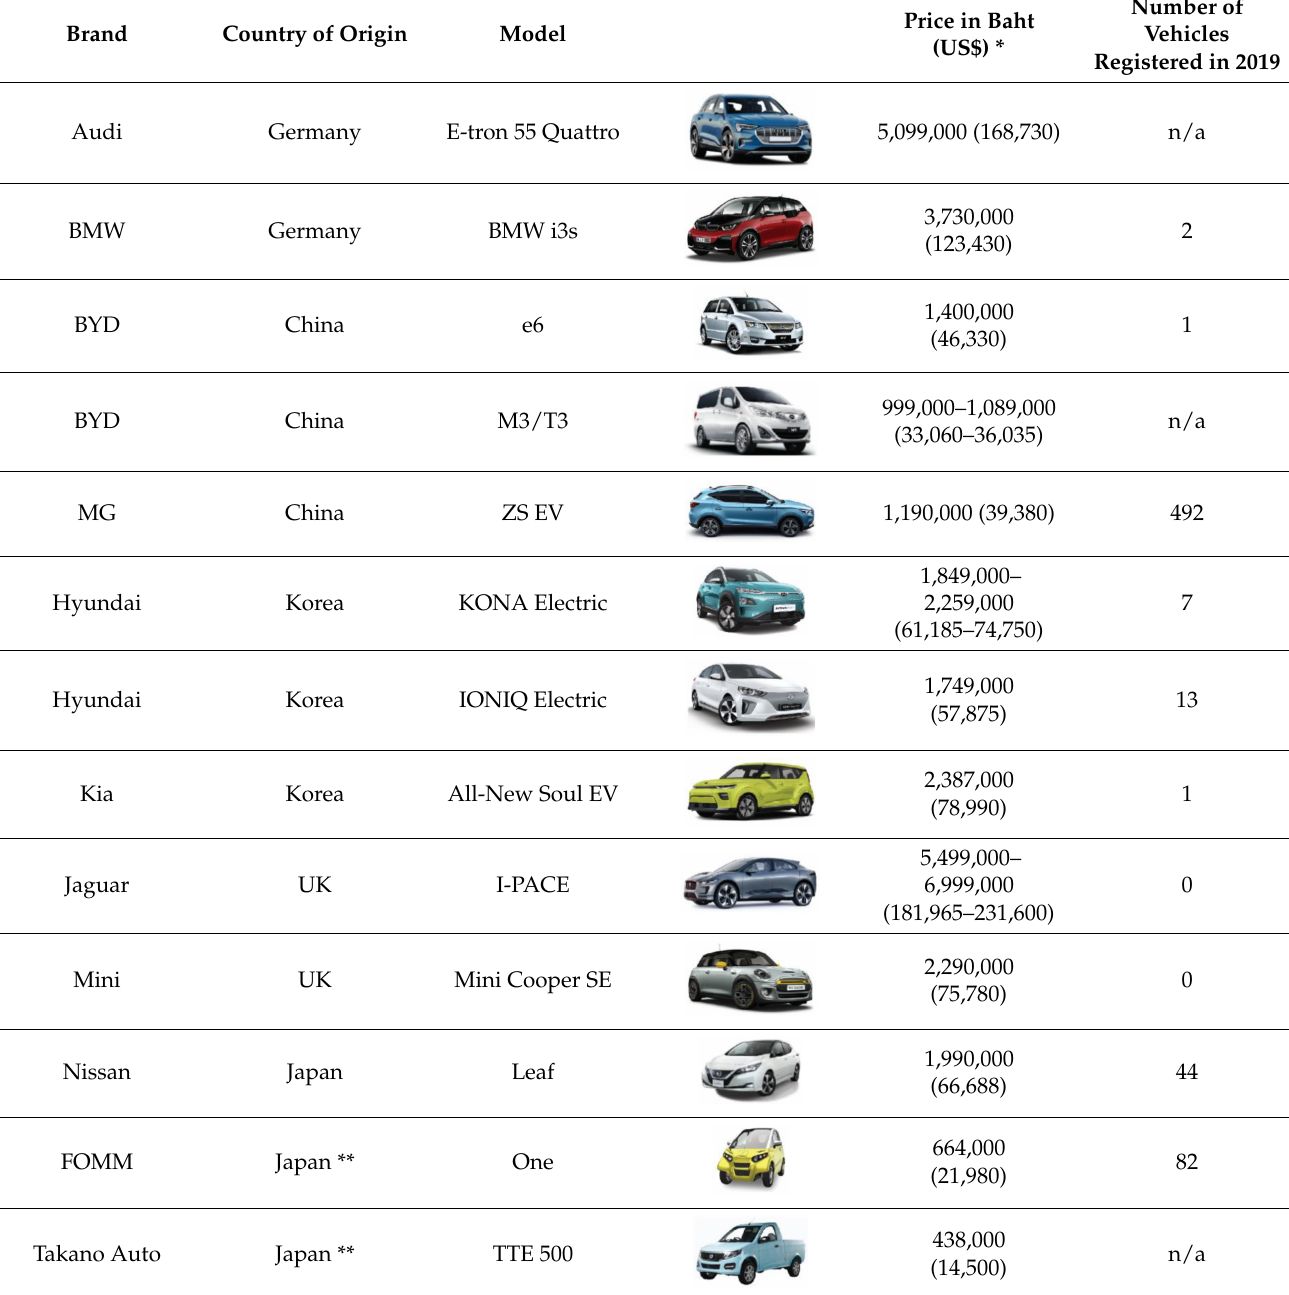
Table 3. Models, brands, retail price, and number of BEV registrations that were available in the Thai market in 2019. Brand Country of Origin Model